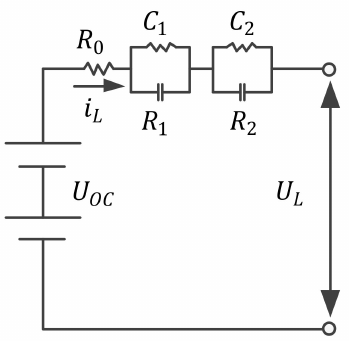
Figure 1. The second-order Thevenin equivalent